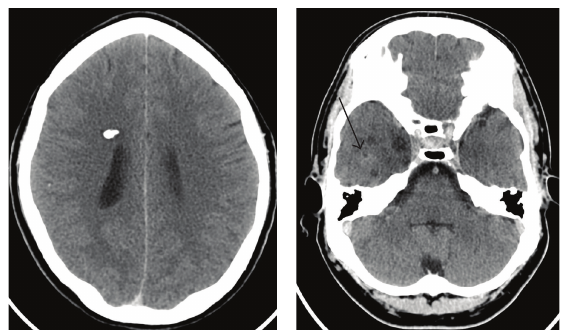
Figure 1: CT scan shows a dense calcified nodule in the subependy- mal aspect on right side and a poorly enhancing area in right temporal lobe (arrow).